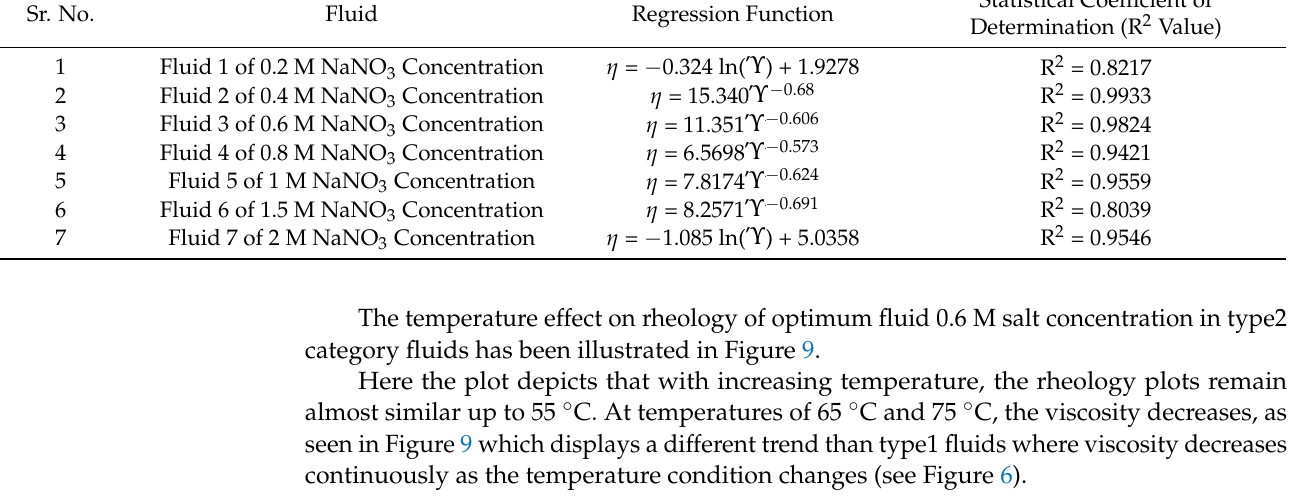
Figure 5. Comparison of viscosity plot of type1 viscoelastic fluids containing 0.8 M and 1.0 M NaNO 3 concentration at different temperatures. Table 1. Regression functions for viscosity change with a varying shear rate of different viscoelas- tic type1 fluids at Temperature 25 °C.